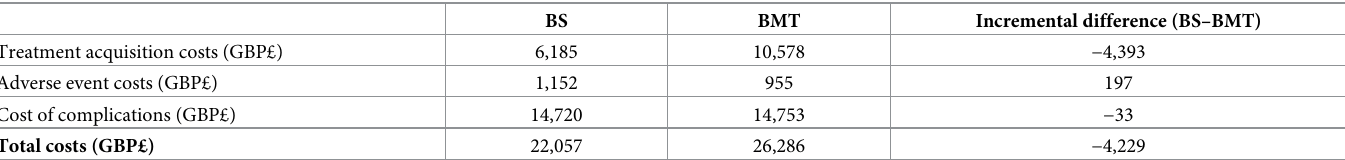
Table 9. Total costs of bariatric surgery and BMT.